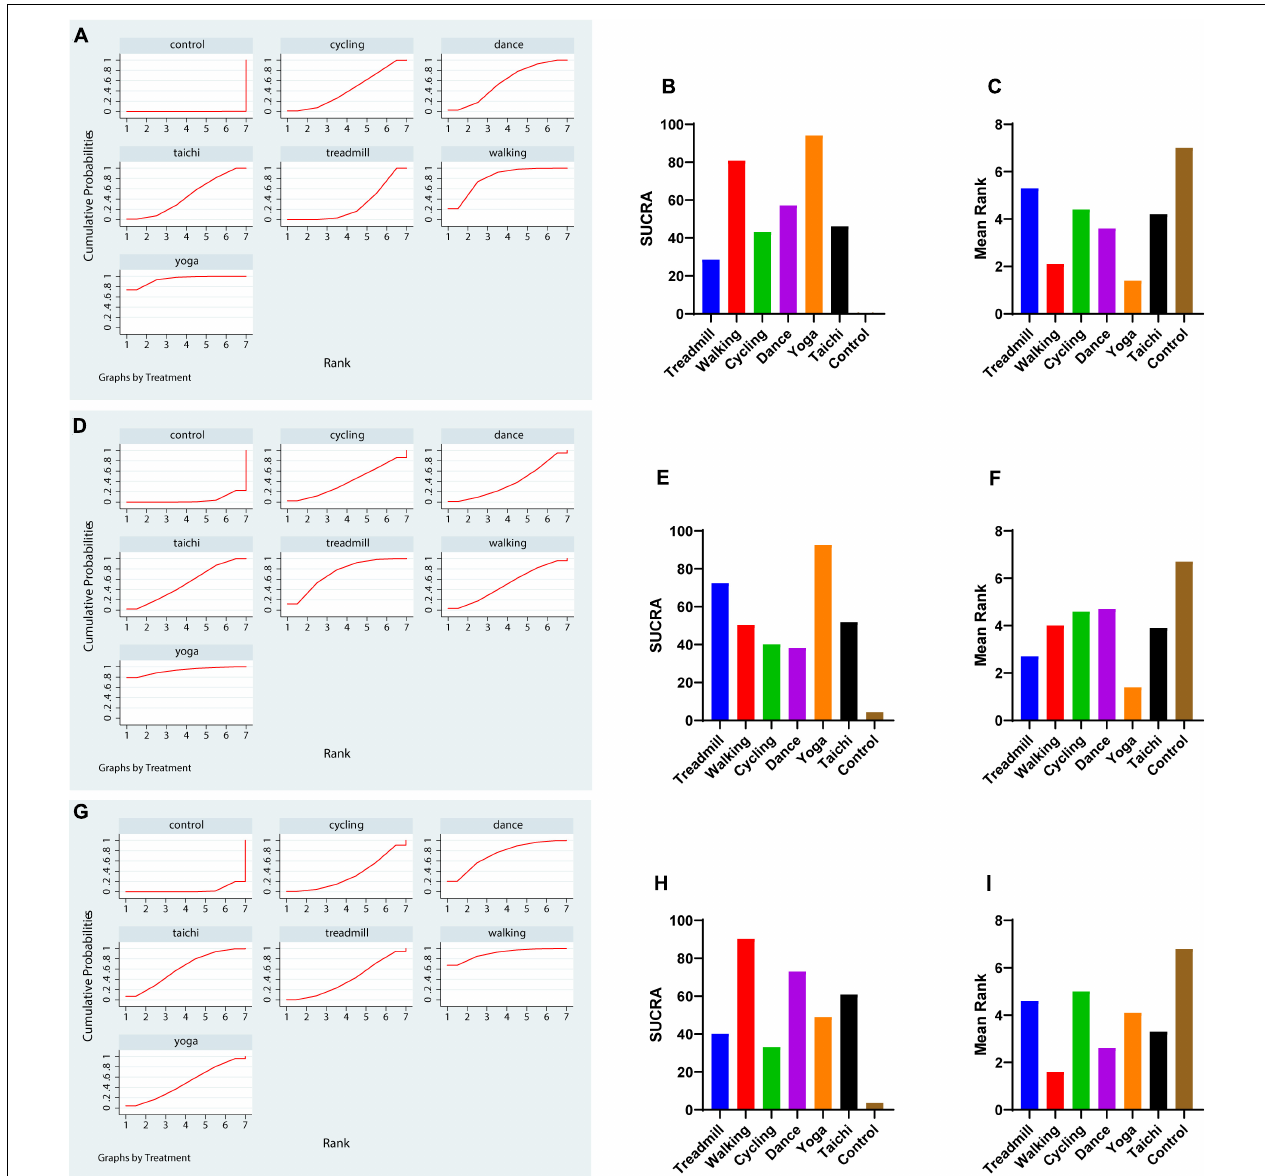
FIGURE 3 | The rank probability of various interventions based on the SUCRA. (A–C) Rank probability and mean rank on UPDRS-motor outcome. (D–F) TUG outcome. (G–I) BBS outcome. The greater the SUCRA value is, the better the